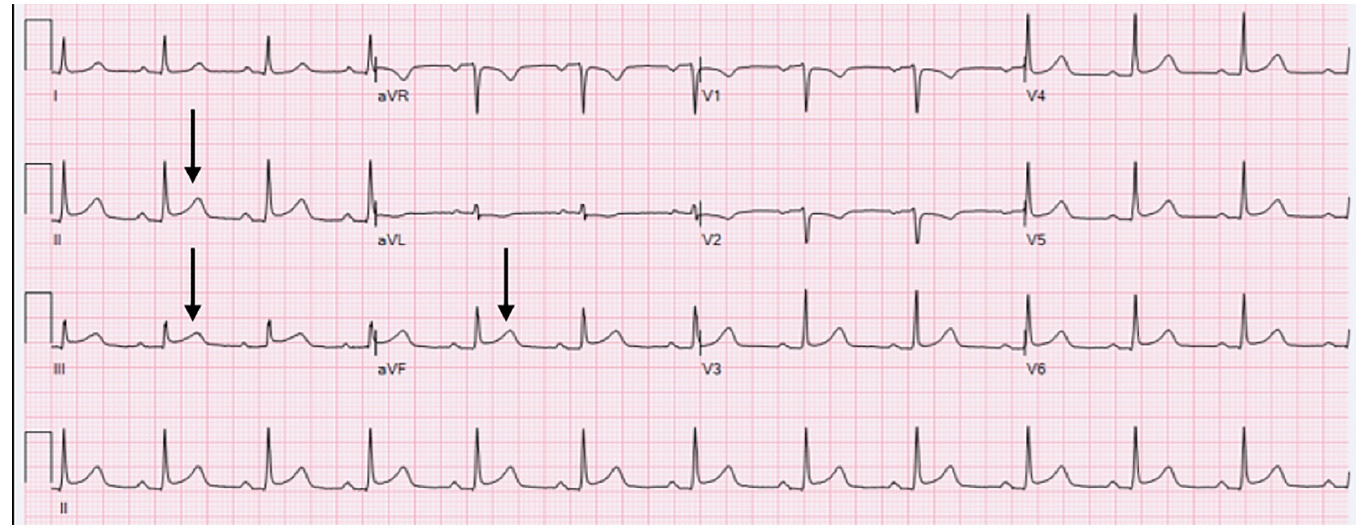
Image 1 . Initial emergency department electrocardiogram. Black arrows indicate ST